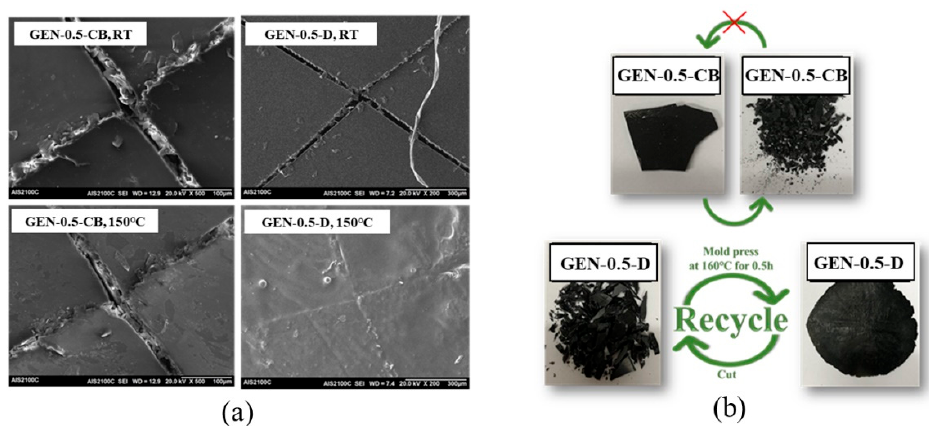
Figure 10. ( a ) SEM images of the scratch healing test for GEN-0.5-CB and GEN-0.5-D, and ( b ) reprocessing of the composites in small pieces with an external force of less than 3 MPa and heat treatment at 160 ◦ C for 0.5